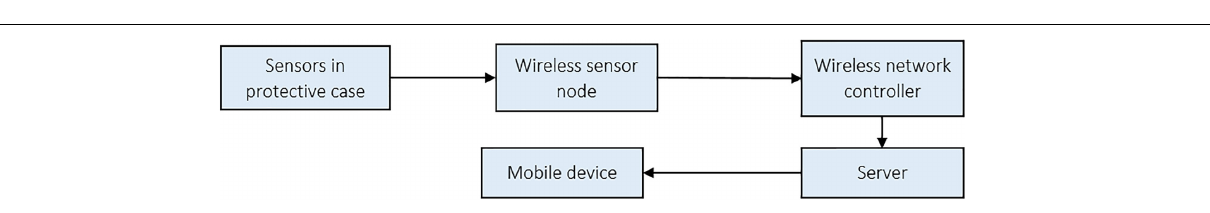
FIGURE 3 | The experimental greenhouse with temperature and relative humidity sensors installed; (A) front view; (B) side view for optimal sensor placement study; and (C) with growing strawberry plants and fan for mechanical ventilation circled in broken red lines.